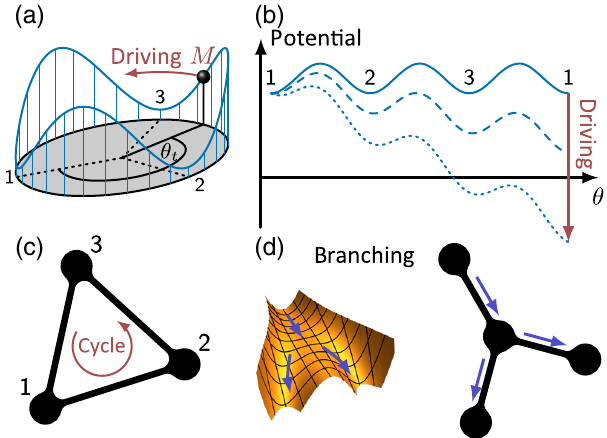
FIG. 2. Rationale and building blocks of coarse graining. (a) – (c) Unicyclic (driven) systems and (d) branching point. (a) Ro- tation angle θ describing a system or observable driven by a t nonequilibrium torque M along a periodic potential with three metastable states. (b) The driving tilts the potential (dashed lines) which leads to work exchange along a cycle 1 → 2 → 3 → 1 . (c) Network representation of (a) as in Fig. 1(e) (for correspond- ing trajectories, see Fig. 12). (d) Multiple cycles require branch- ing points (blue arrows), for example, generated by a multidimensional force field with a local pitchfork bifurcation [14] (left panel depicts the corresponding local